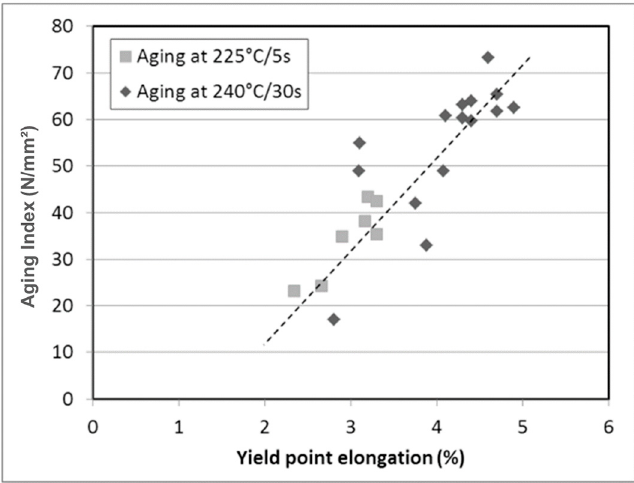
Figure 9. The relationship between aging index and YPE.